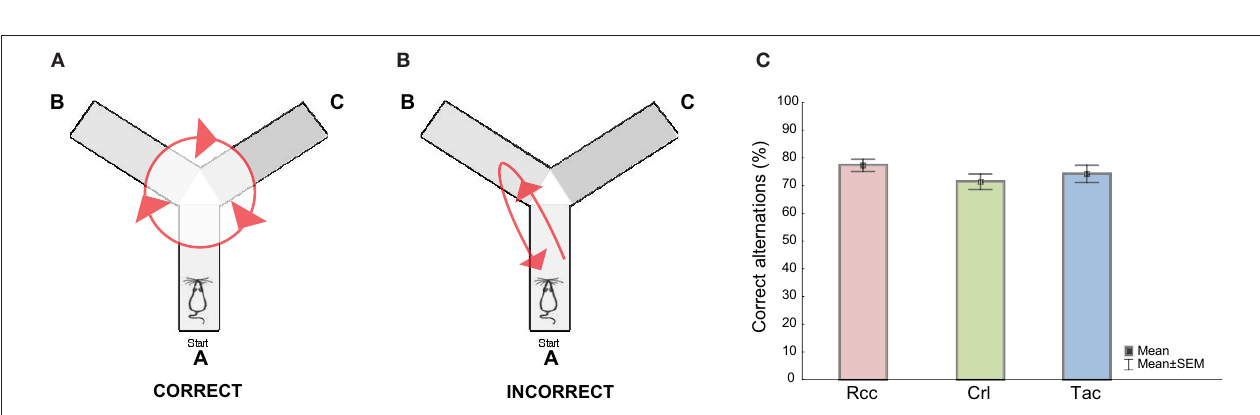
FIGURE 2 | Schematic illustration showing examples of (A) a correct and (B) an incorrect alternation in the Y-maze test, and (C) the level (%) of correct alternations when comparing Wistar rats from different suppliers, i.e., RccHan TM :WI (Rcc), Crl:WI (Crl), and HanTac:WH (Tac). Data are presented as mean ± SEM (ANOVA, Fisher’s LSD post-hoc test